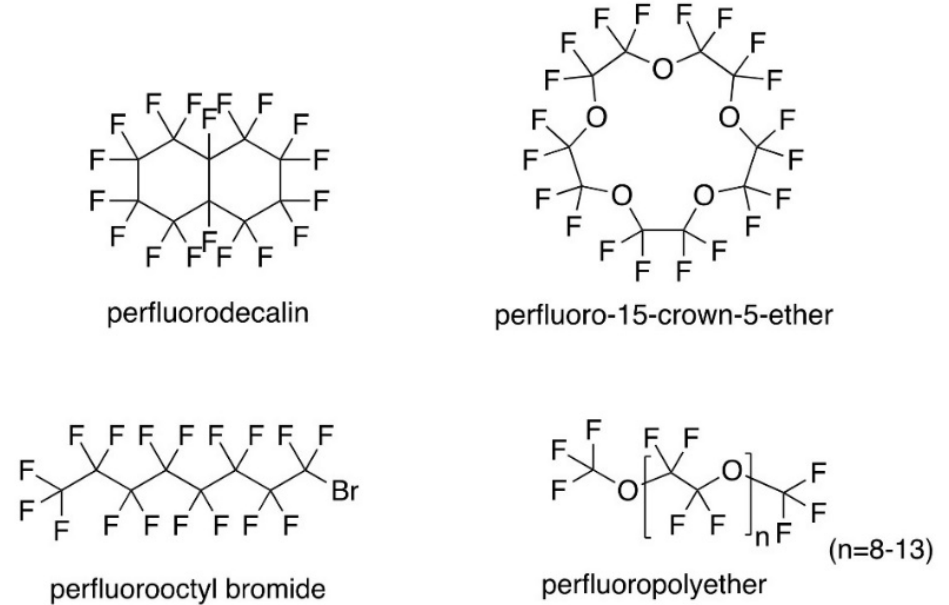
Figure 1. Chemical structures of the four perfluorocarbons selected for incorporation into nanoemulsions: perfluorodecalin (PFD), perfluoro-15-crown-5-ether (PCE), perfluorooctyl bromide (PFOB), and perfluoro(polyethylene glycol dimethyl ether) oxide (PFPE).